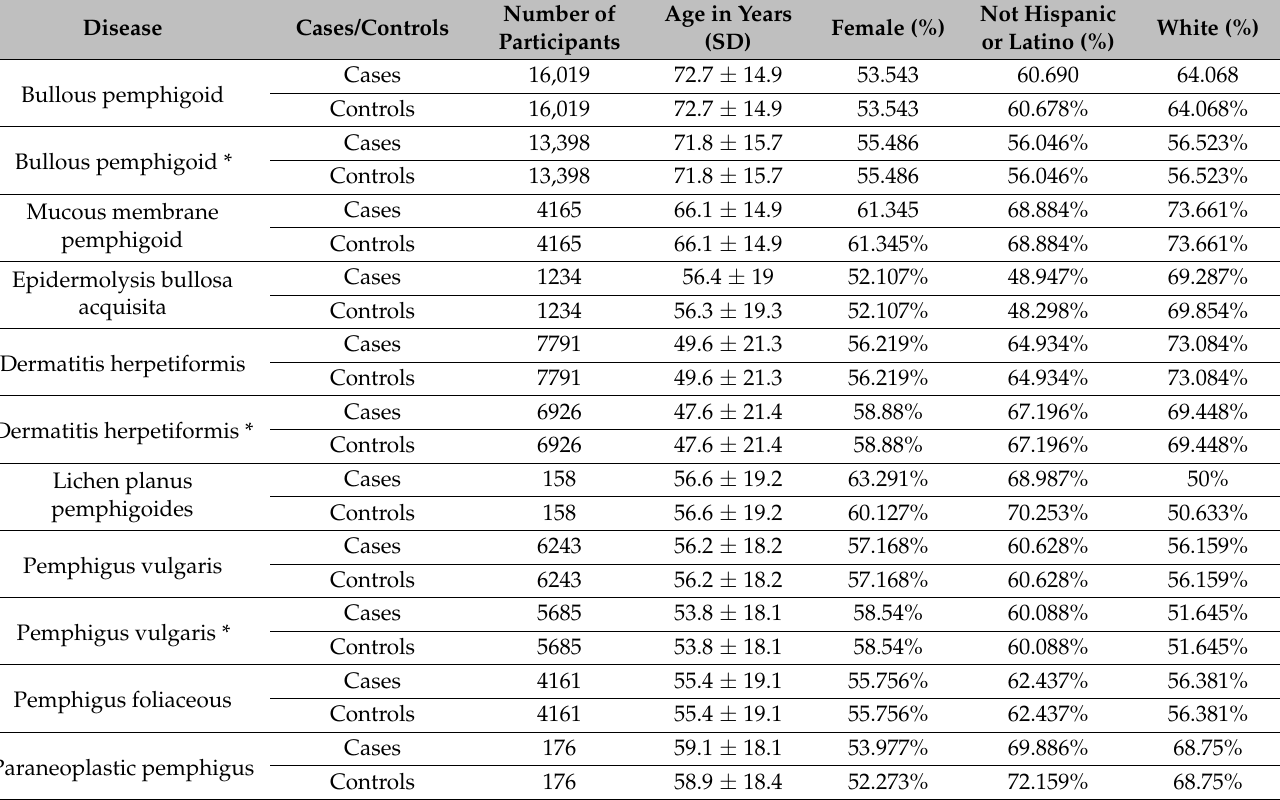
Table 2. Cohort description for pemphigus and pemphigoid diseases. Abbreviations: SD: standard deviation. * Cases and controls with elevated bilirubin or urea nitrogen concentrations in serum, plasma, or blood were excluded from